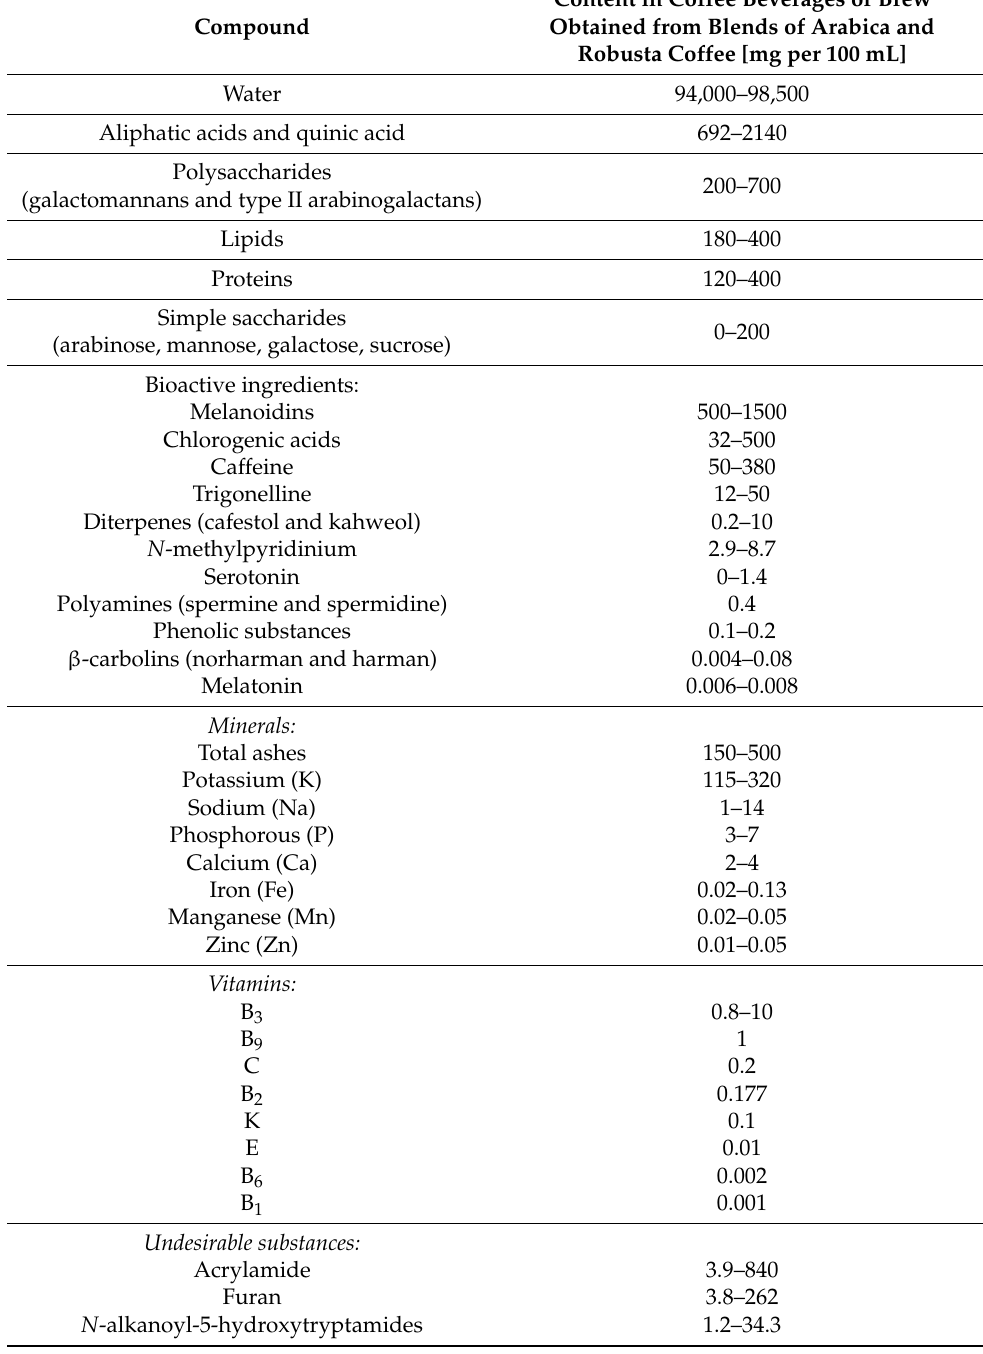
Table 2. The chemical composition of coffee beverages or drew